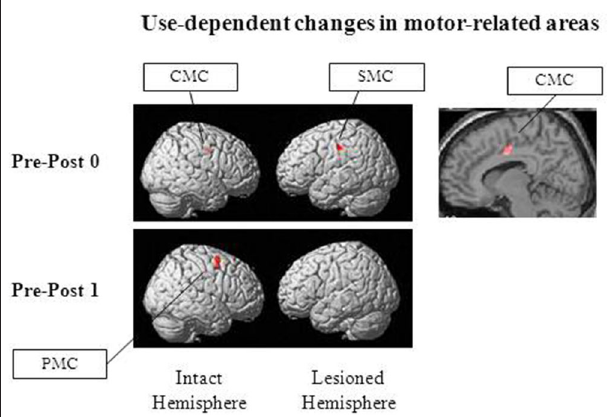
FIGURE 1 | Brain regions with use-dependent task-specific changes . Reduced activation was observed in the ipsilesional SMC, the contralesional cingulate motor cortex (CMC) and the contralesional premotor cortices (PMC), specifically for extensor movements of the paretic upper-limb after our combination therapy consisting of 5 Hz repetitive transcranial magnetic stimulation (rTMS) and the paretic extensor training in post-stroke patients with flexor hypertonia (“Post 0” and “Post 1”, immediately after and 2 weeks after the combination therapy, respectively). Adapted from Koganemaru et al.